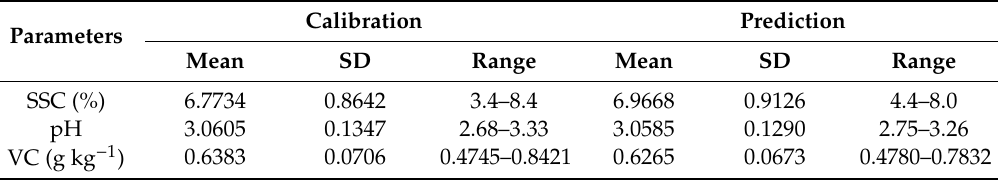
Table 1. SSC, pH, and VC statistics of 120